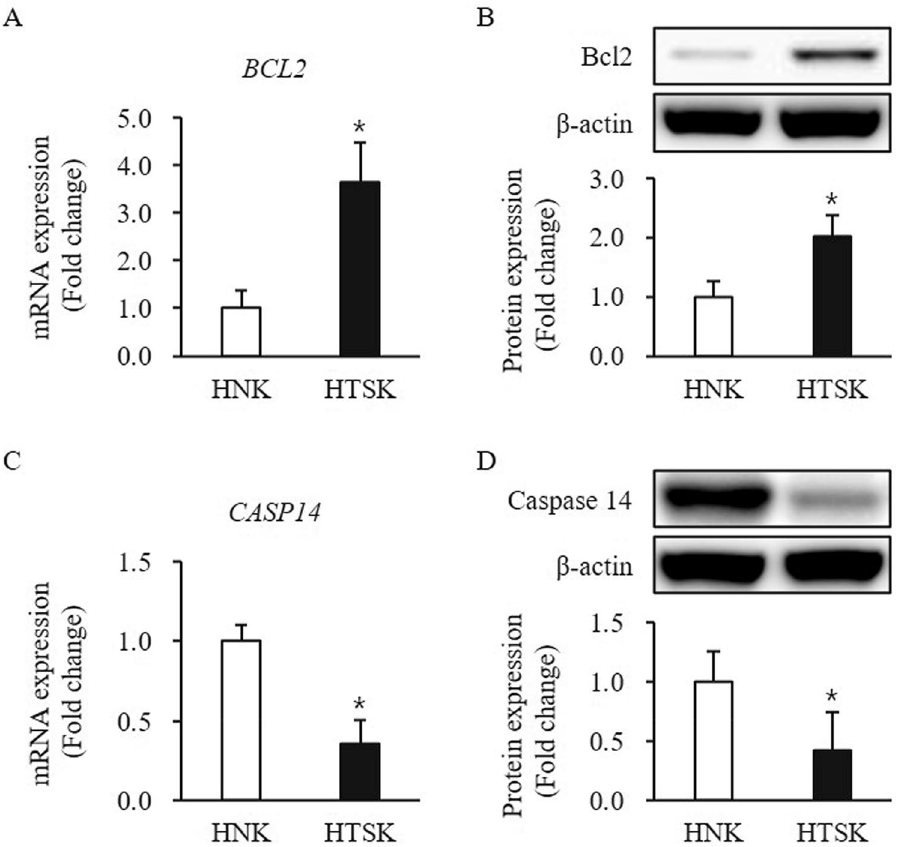
Figure 3. Expression of apoptosis-related factors in HTSKs. Significantly increased mRNA levels of genes encoding bcl2 ( BCL2 ) (A) and decreased mRNA levels of genes encoding caspase 14 ( CASP14 ) (C) in HTSKs compared with those in HNKs. Significantly increased protein levels of bcl2 (B) and decreased protein levels of caspase 14 (D) in HTSKs compared with those in HNKs. NHKs and HTSKs were primary cultured from normal skin tissues and HTS tissues, respectively. In the fold change, HNKs marked as value 1; HNK, human normal keratinocyte; HTSK, hypertrophic scar keratinocyte; * P < 0.05 for HTSK vs. the corresponding matched HNK. Data represent means ± SD; n = 4 (HNK) and n = 4